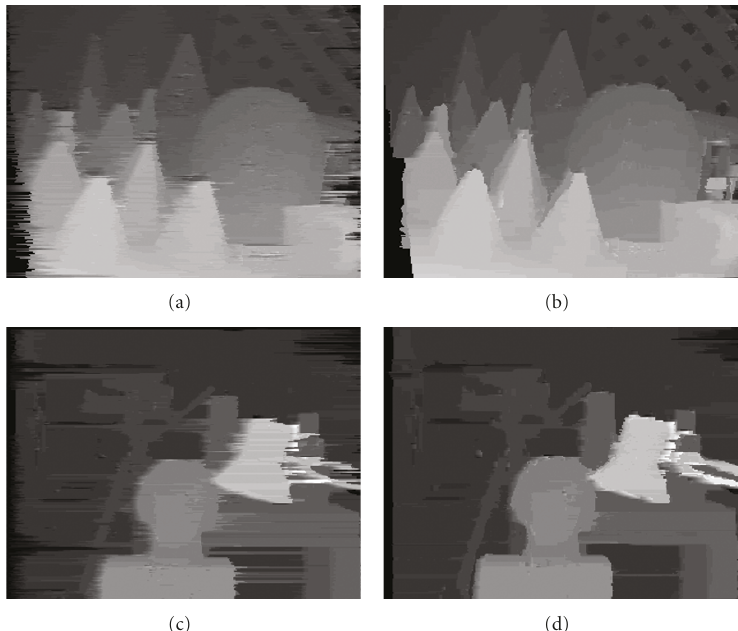
Figure 18: (b) and (d): Results from the DP system with interscanline support. (a) and (c): Results from the plain DP system shown for comparison.